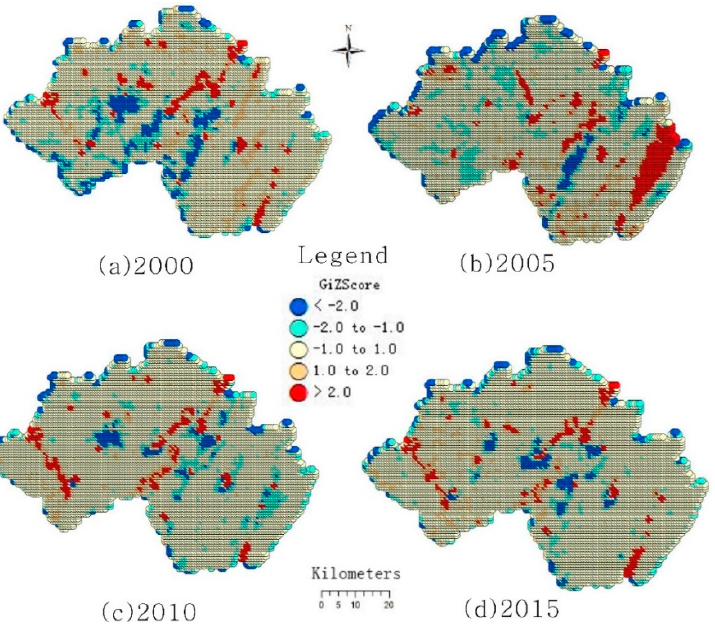
Figure 4. The spatial differentiation maps of cold and hot spots in 2000, 2005, 2010, and 2015 [19].( a ) The spatial differentiation maps of cold and hot spots in 2000 ( b ) The spatial differentiation maps of cold and hot spots in 2005 ( c ) The spatial differentiation maps of cold and hot spots in 2010 ( d ) The spatial differentiation maps of cold and hot spots in